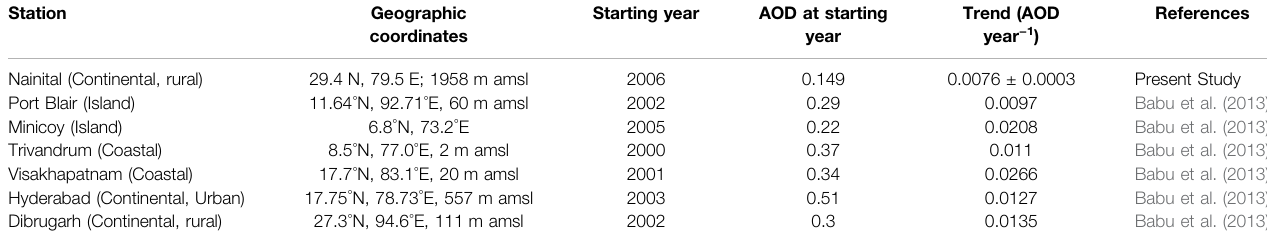
TABLE 3 | Comparison of the AOD trend observed at Nainital site with the reported trends over other Indian sites. Station